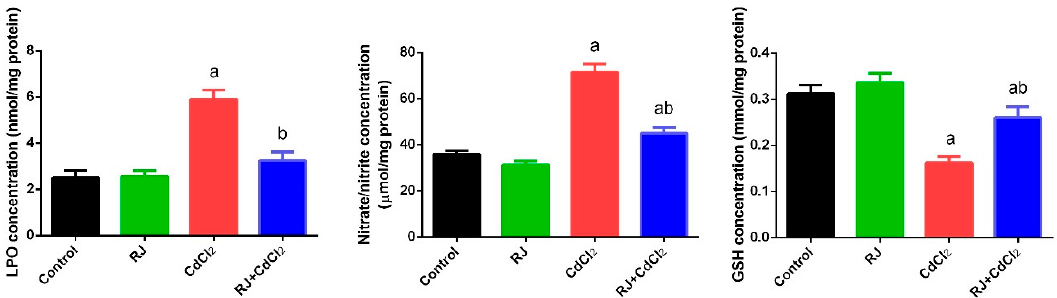
Figure 4. Effects of royal jelly (RJ) on lipid peroxidation (LPO), nitrate/nitrite, and reduced glutathione (GSH) levels in testes of mice exposed to cadmium chloride (CdCl 2 ). All values are expressed as mean ± SEM (n = 7). a refers to a significant change from the control mice at p < 0.05; b refers to a significant change from the CdCl 2 -treated mice at p < 0.05, using Duncan’s post hoc test.